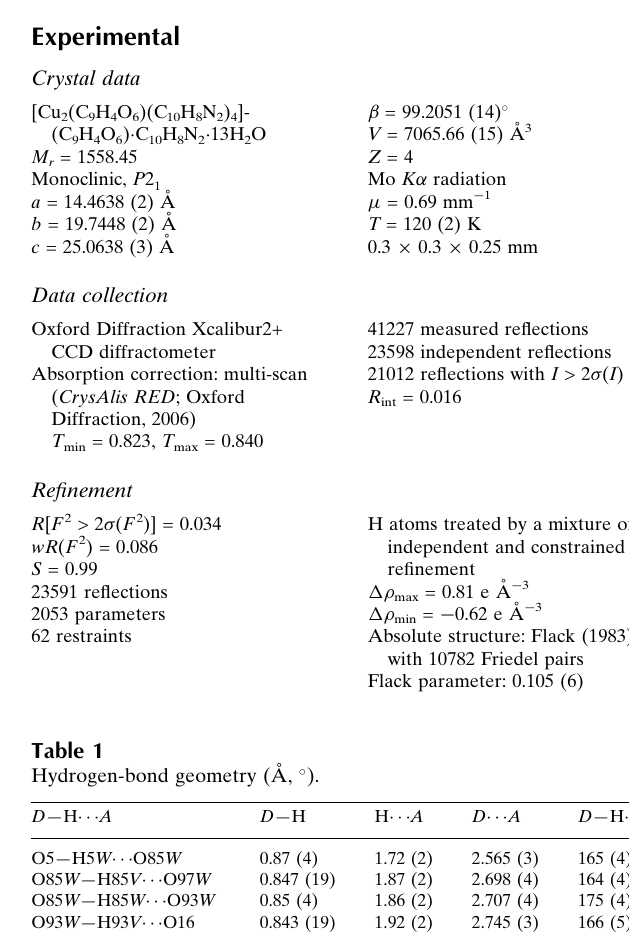
Absorption correction: multi-scan ( CrysAlis RED ; Oxford Diffraction, 2006) T min = 0.823, T max = 0.840